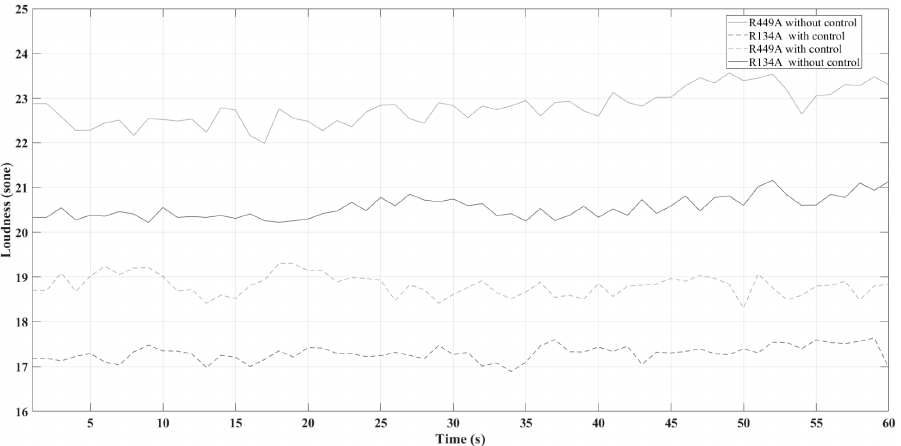
Figure 7. Loudness for R-449A and R-134A refrigerant gases with and without control system.